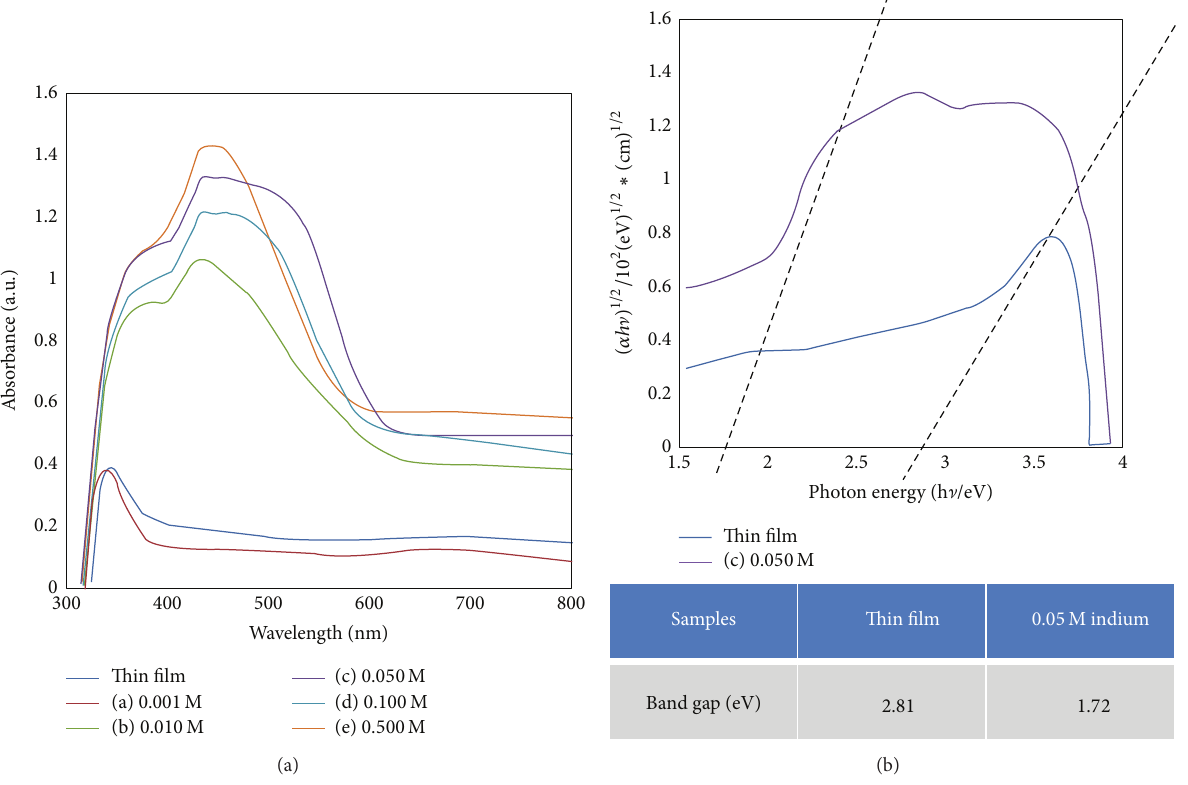
Figure 3: UV-visible absorption spectra (a) and Tauc’s plots (b) of the TiO 2 seed blocking/In 2 S 3 photosensitizer (0.001, 0.01, 0.05, 0.1, and 0.5 M) layered